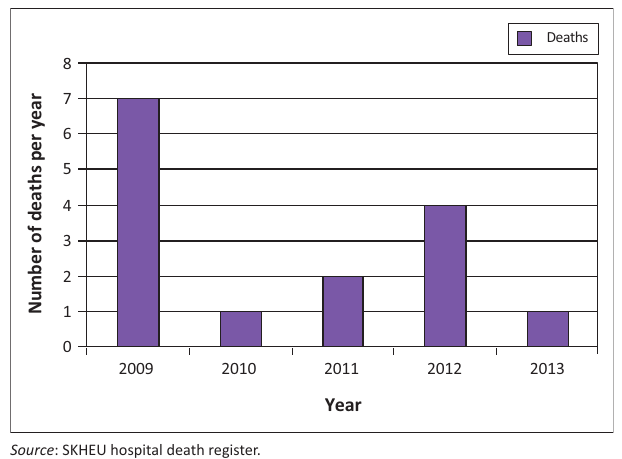
FIGURE 2: Distribution of deaths per